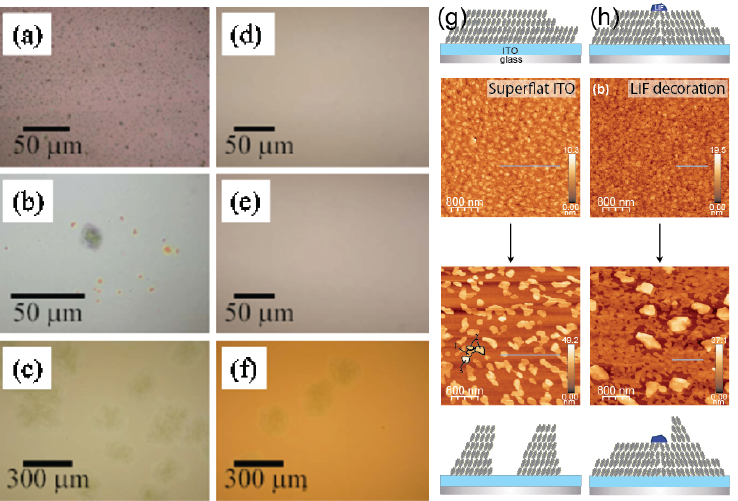
Figure 10. Optical micrographs of ( a – c ) an undoped ITO/NPB 10 nm/NPB 50 nm sample morphol- ogy: ( a ) before annealing, ( b ) after 120 °C annealing, and ( c ) after 140 °C annealing; and ( d – f ) of an ITO/NPB:LiF (5 wt %) 10 nm/NPB 50 nm sample morphology: ( d ) before annealing, ( e ) after 120 °C annealing, and ( f ) after 140 °C annealing. Reprinted from Ref. [156], with the permission of AIP Publishing. ( g ) Morphology of neat di-indenoperylene (DIP) deposited on superflat ITO. ( h ) Morphology of DIP on superflat ITO with thermally evaporated LiF nanoparticle decoration. Top panels are the as-deposited morphology, middle panels are AFM micrographs before and after at least one month storage in an evacuated dessicator. The bottom panels show the schematic of DIP structure with significant dewetting of DIP on ITO, stabilized by LiF nanoparticle pinning at DIP grain boundaries. Lines indicate height profiles (not shown). Adapted from Ref. [157], copyright (2013) with permission from